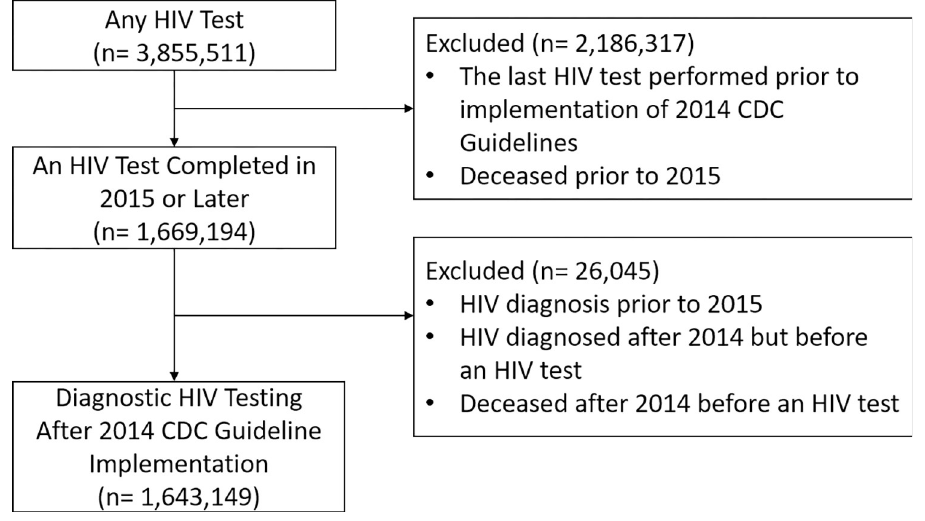
Fig 2. Determination of study